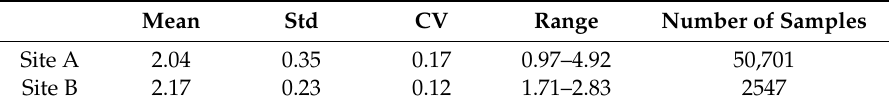
Table 2. Statistics of Chl-a ( µ g/L) at of Poyang Lake in 2013 and